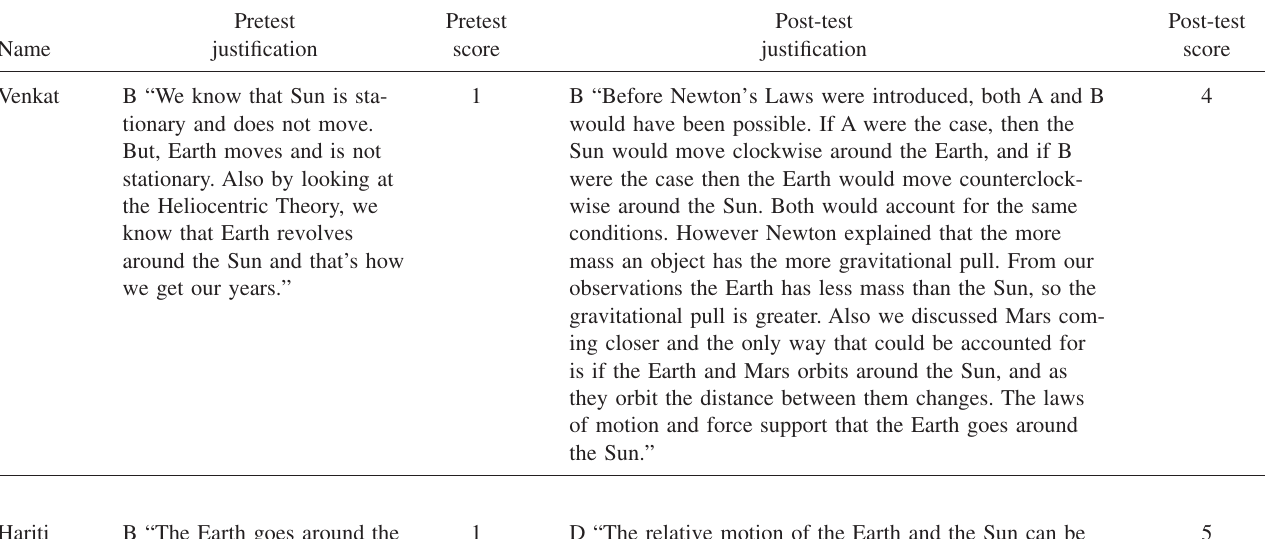
TABLE II. Sample verbatim matched pre-post-responses to scientific argument question shown in Fig. 1. Pretest and Post-test refer to prior to after instruction. A, B, C, and D refer to the multiple choice response given to the